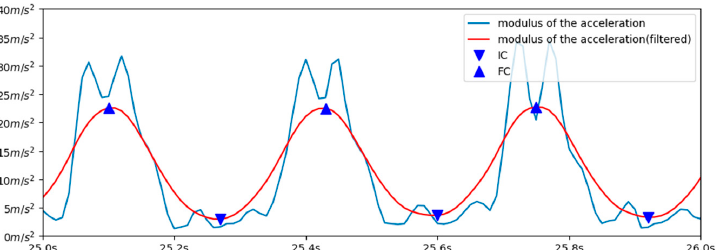
Figure 6. Blue line: modulus of the acceleration obtained from the upper-back-mounted inertial sensor. Red line: low pass filtered acceleration. IC and FC events are indicated by a downward triangle and an upward triangle, respectively.